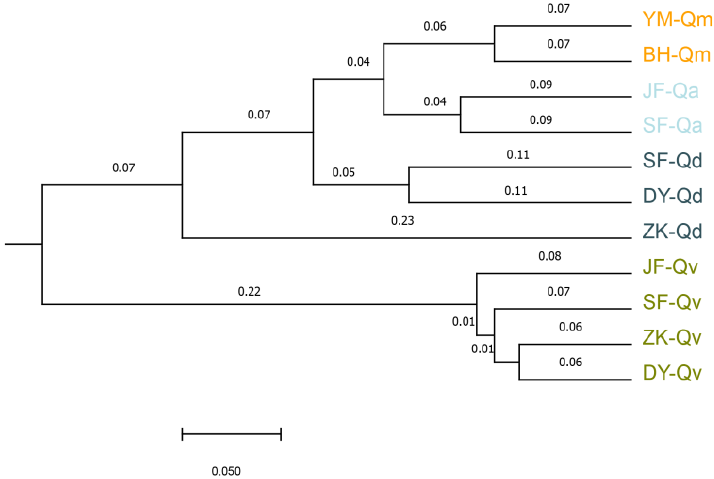
Figure 4. The UPGMA analysis of populations from different regions. Eleven populations mentioned